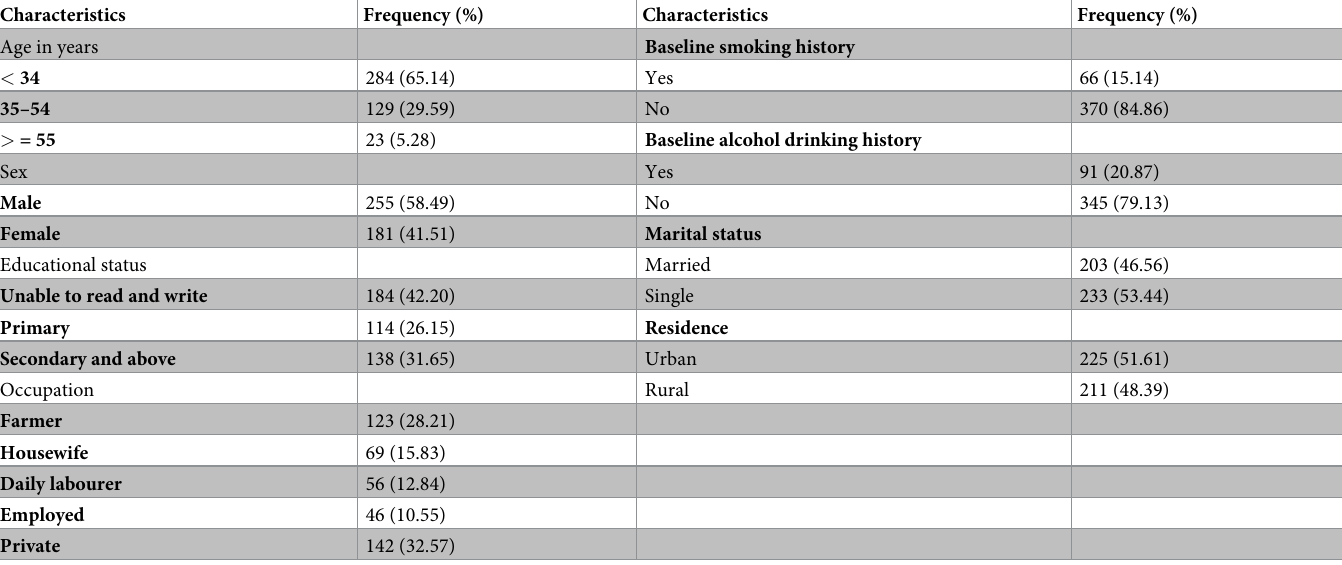
Table 1. Socio-demographic characteristics and behavioural among DR-TB patients in North West Ethiopia (N = 436).